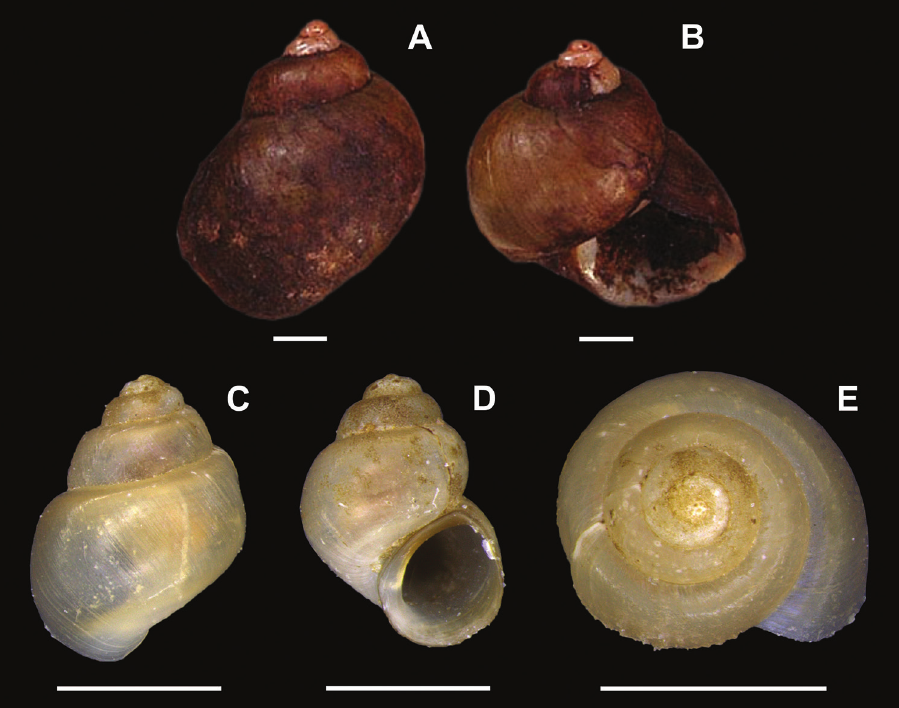
Figure 4. Potamolithus ribeirensis - A (dorsal view) B (apertural view); Potamolithus sp. 1 C (dorsal view) D (apertural view) E (apical view). Scale bars: 1mm. (Photographs: LBR